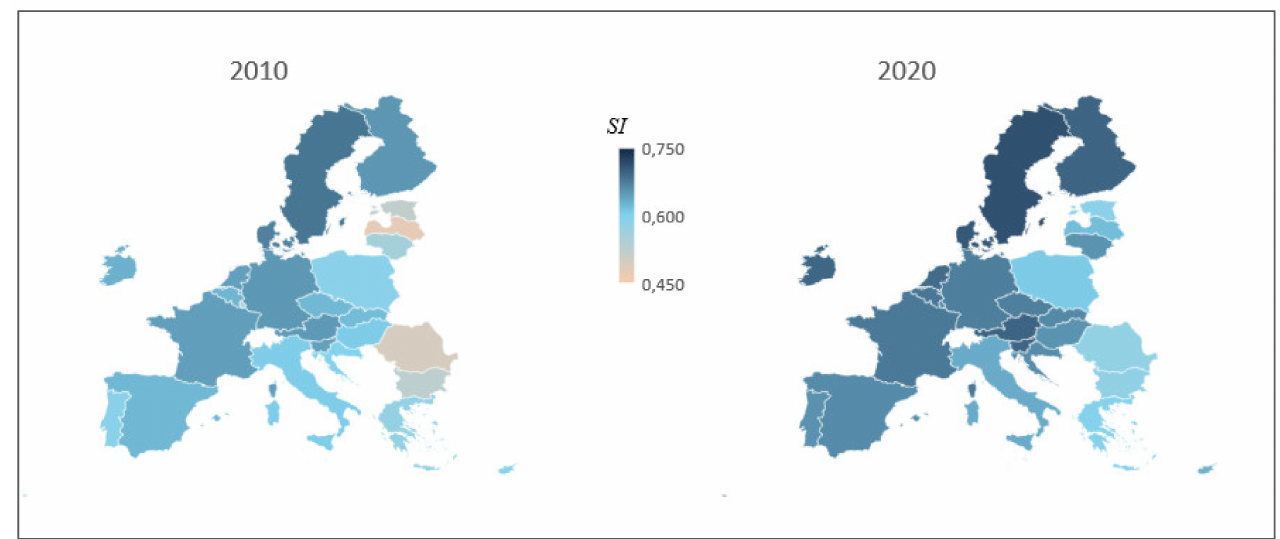
Figure 1. Sustainability Index ( SI ) scores for 2010 and